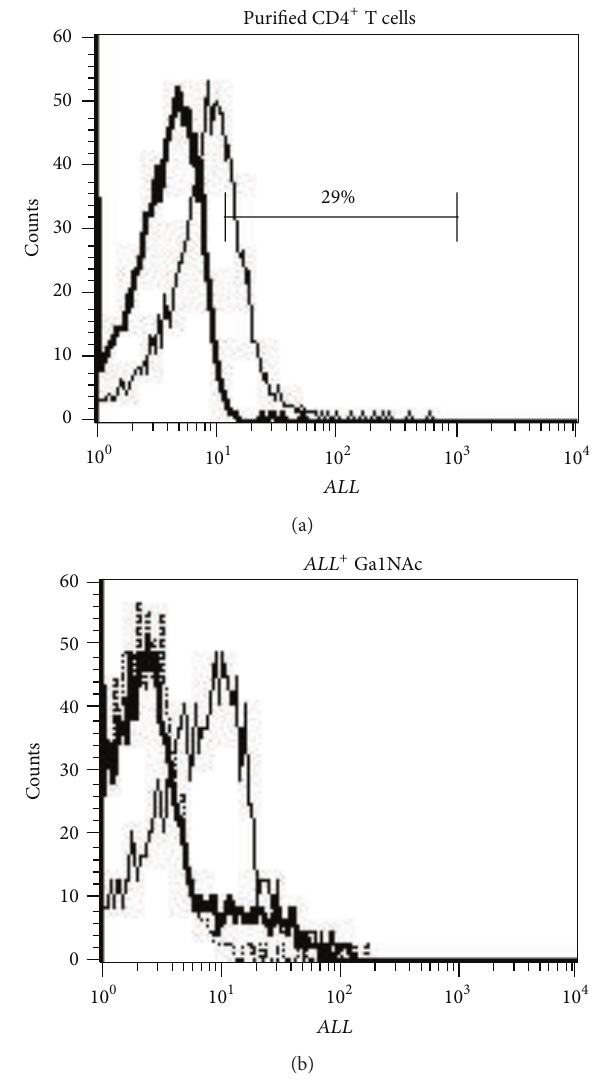
Figure 1: ALL recognizes purified CD4 + T cells. (a) Freshly purified CD4 + T cells were stained with CyChrome-labeled streptavidin alone (thick line) after incubation with biotin-labeled ALL (thin line). The bar denotes percentage of purified ALL + CD4 + T cells. (b) GalNAc inhibited Amaranthus leucocarpus lectin ( ALL ) binding sites for CD4 + T cells. Gray lines denote the staining of cells treated onlywithCyChrome-streptavidin;thinlineindicatestheflorescence level of ALL + cells; thick line denotes fluorescence of ALL + cells when they were treated with GalNAc.